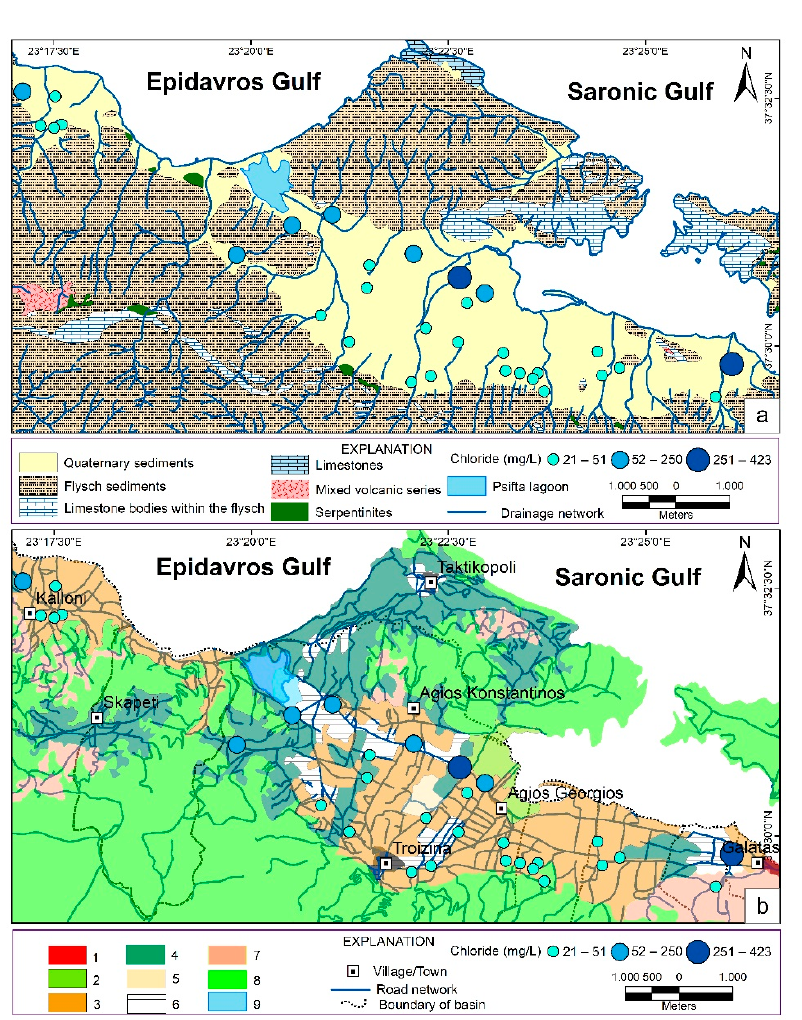
Figure 4. Graduated symbol plots of chloride content in groundwater of the study area compared with ( a ) geology and ( b ) land uses (the explanation of land uses is shown in the caption of Figure 2).